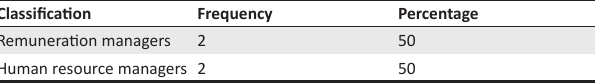
TABLE 2: Focus group of remuneration and human resource managers.